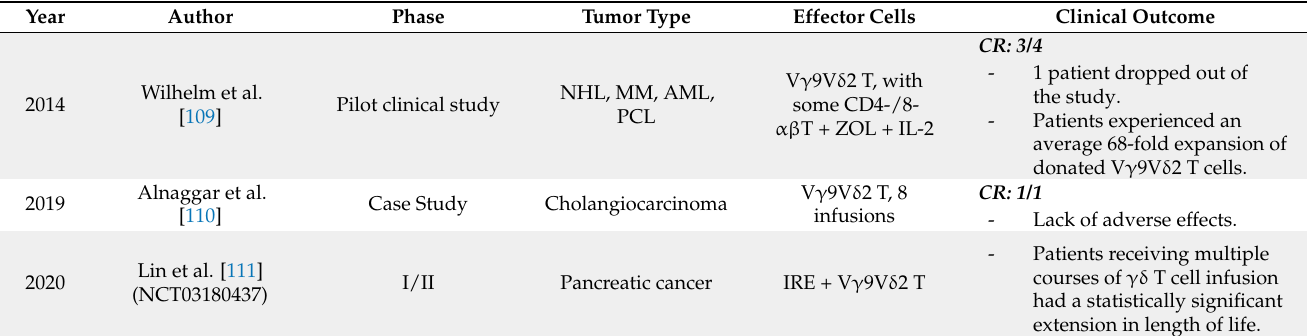
Table 3. Allogeneic, ex vivo expanded γδ T cell clinical trials.